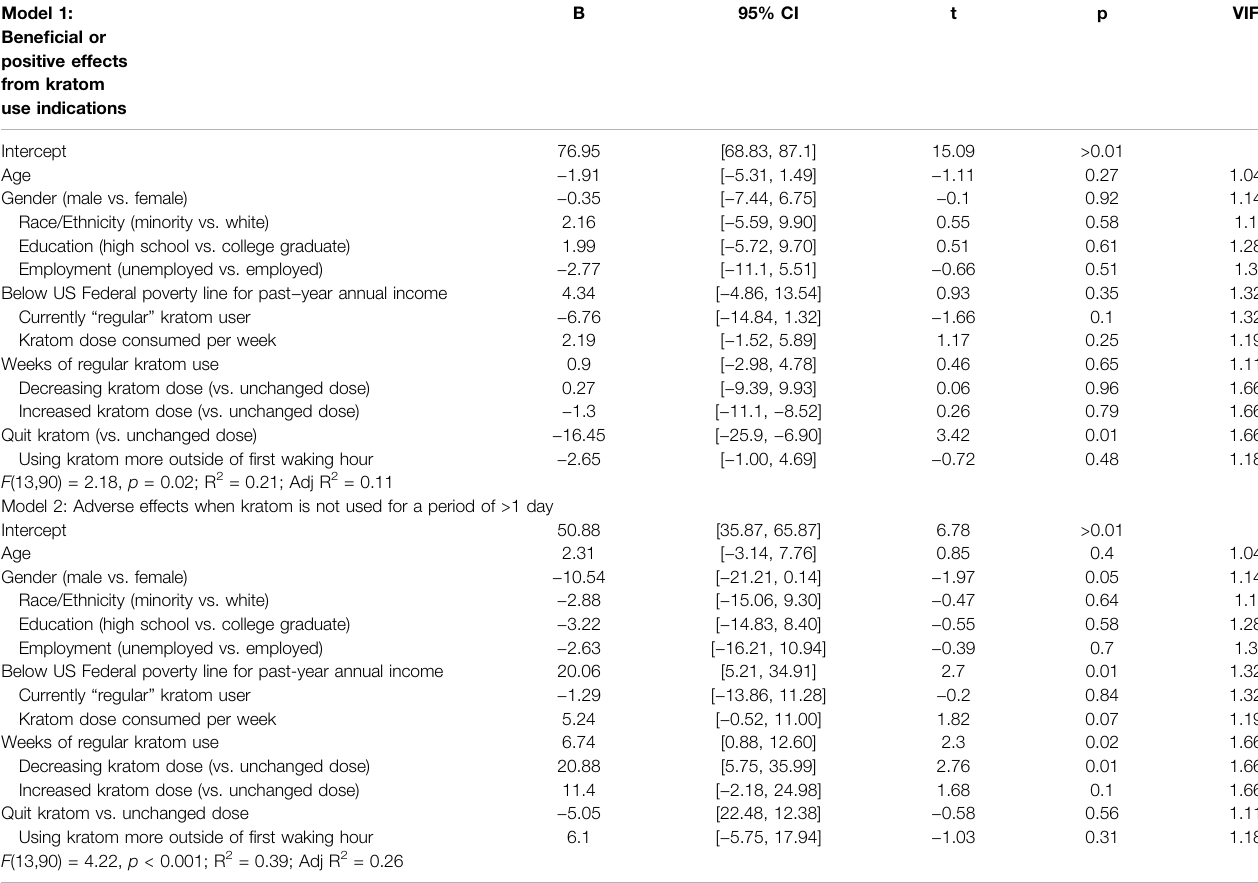
TABLE5| Model1displaysresultsfromamultipleregressionthatexaminespooledVASratingsofbene fi cialeffectsfromkratomuse.Model2examinespooledVASratings of adverse or unwanted effects when kratom is not used for ≥ 1 day. Model 1: Bene fi cial or positive effects from